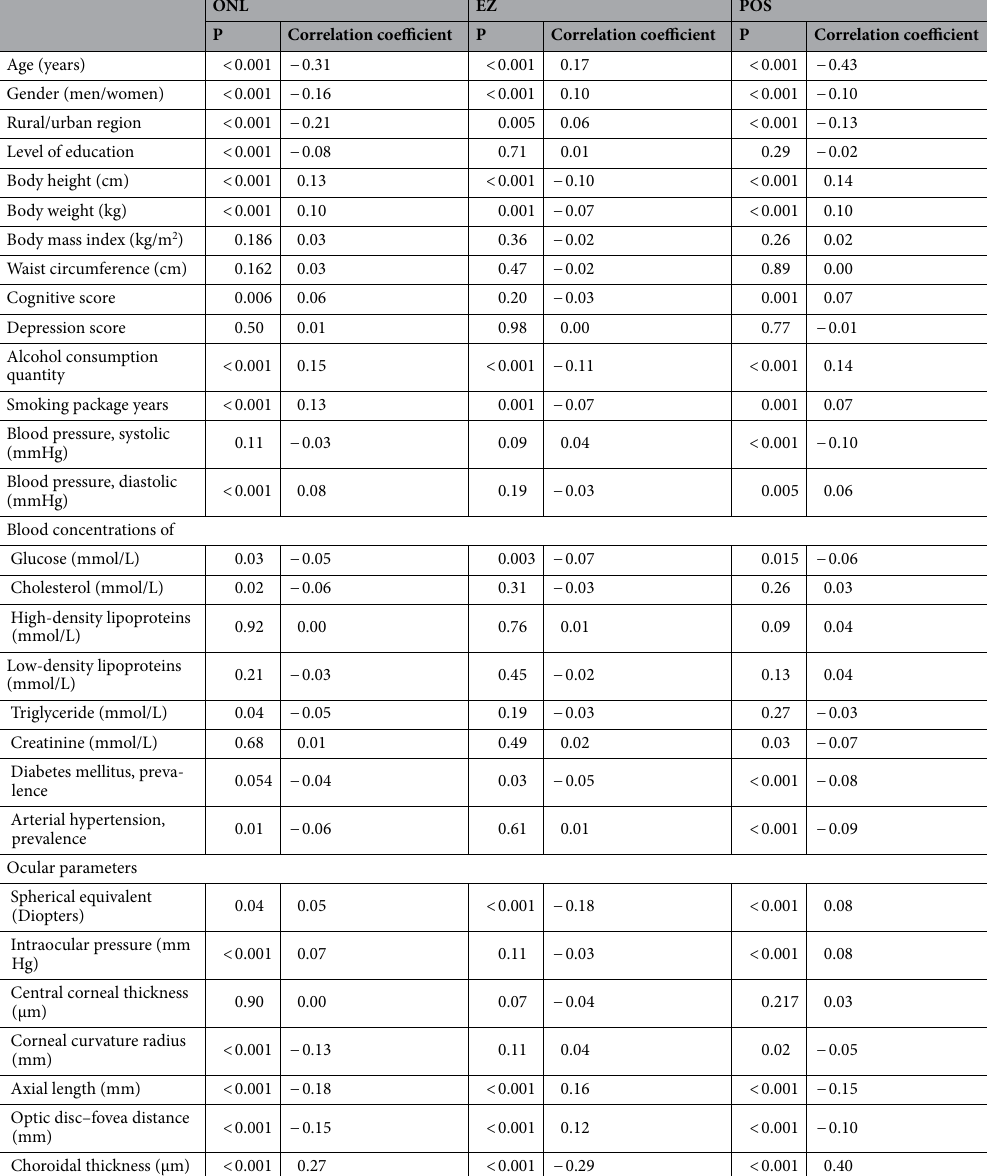
Table 2. Associations between the thickness of the retinal outer nuclear layer (ONL), the ellipsoid zone (EZ), the photoreceptor outer segment band (POS), with ocular and systemic parameters in a univariable analysis. The thickness of each layer/band was calculated as the mean value of all 9 Early Treatment Diabetic Retinopathy Study (ETDRS)